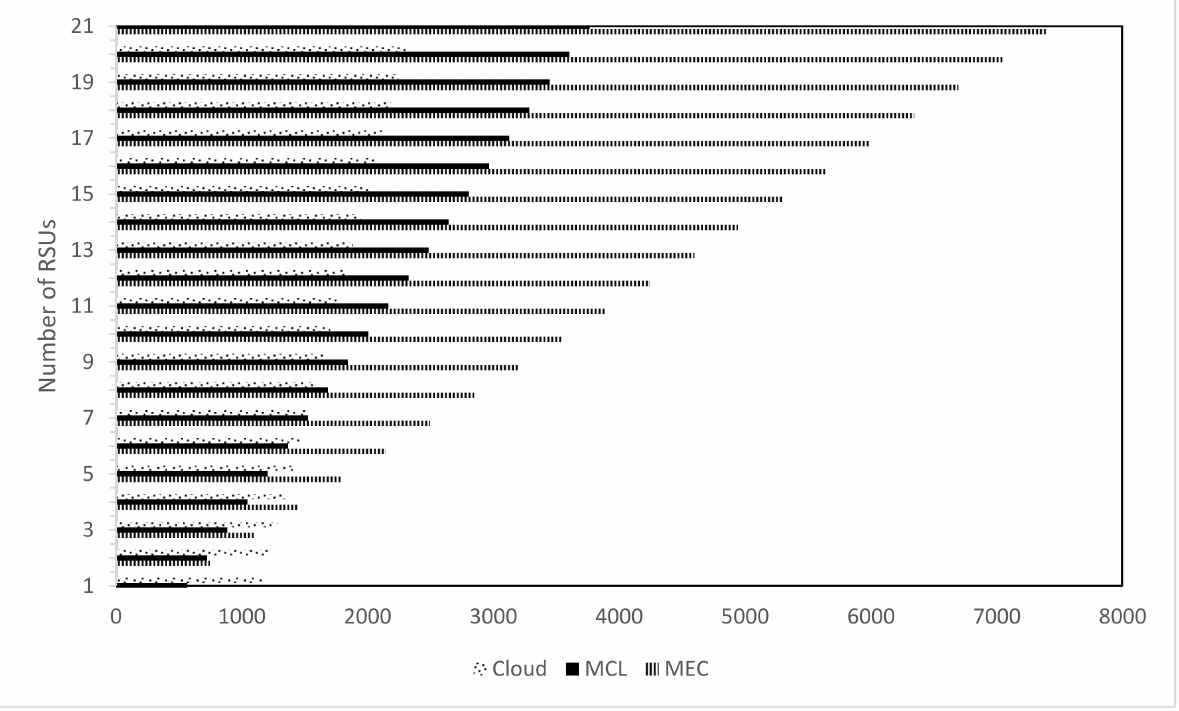
Figure 10. Network Latency with Fixed SVs and variable